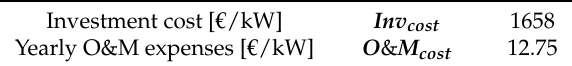
Table 2. PV system costs. Source: